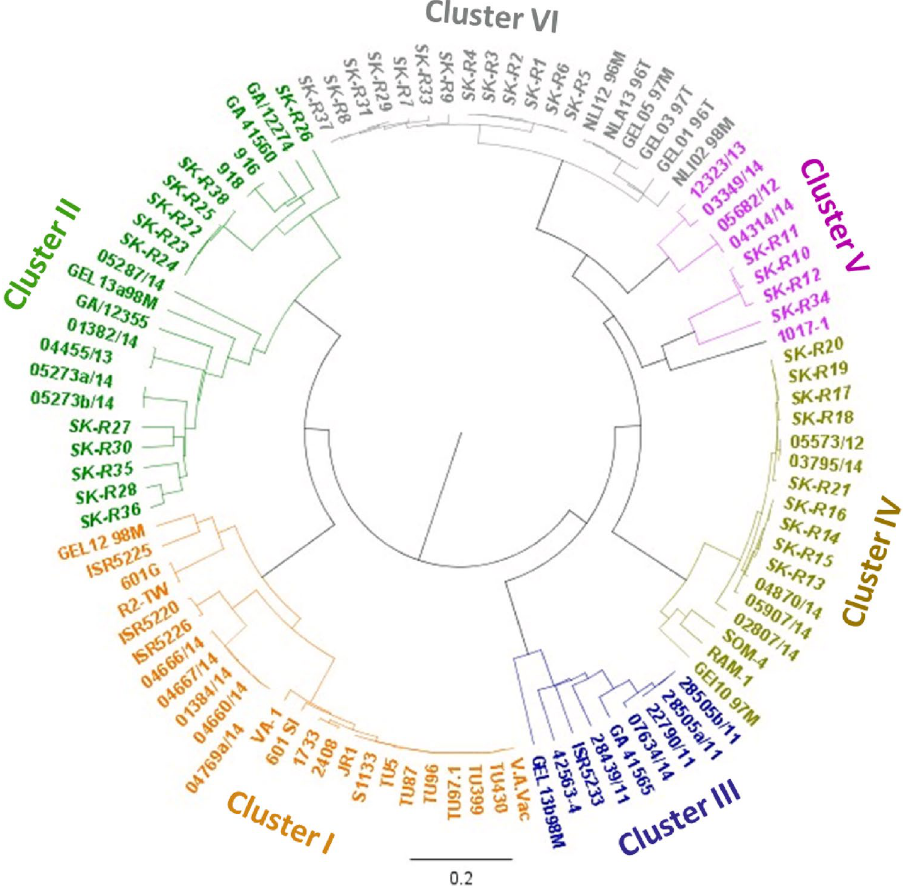
Figure 5. Phylogenetic tree of ARV strains based on the Sigma C sequence variability. The tree shows genetic relationship between the Sigma C protein sequence of 37 field isolates and 63 reference and variant strains isolated from around the world. The virus strains clustered into six genotyping groups (color coded). Our isolates are highlighted in bold. The tree was built by Neighbor joining method with Jukes-Cantor genetic distance